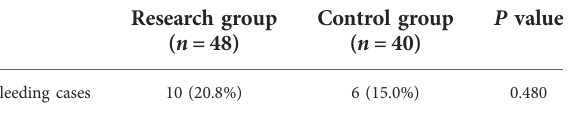
TABLE 4 Comparison of postoperative bleeding rate between two groups of patients.